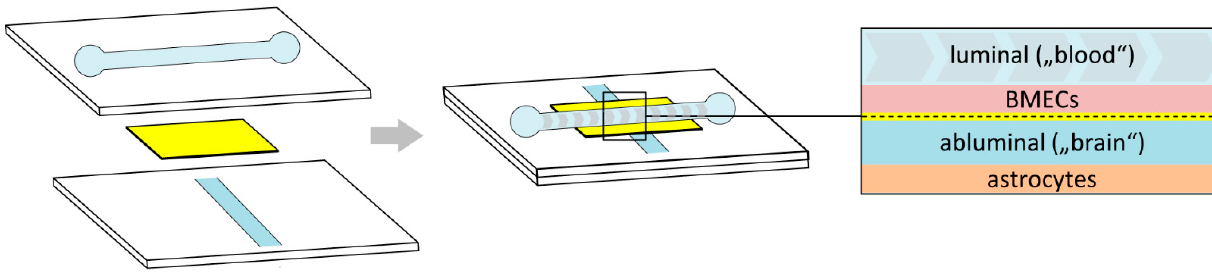
Figure 9. Microfluidic-based dynamic blood–brain barrier (BBB) models. Most microfluidic-based dynamic BBB models integrate the monolayer of brain microvascular endothelial cells (BMECs) into a planar, microfluidic network that allows for co-culture with one or more additional cell types and introduction of fluid flow-induced shear stress.